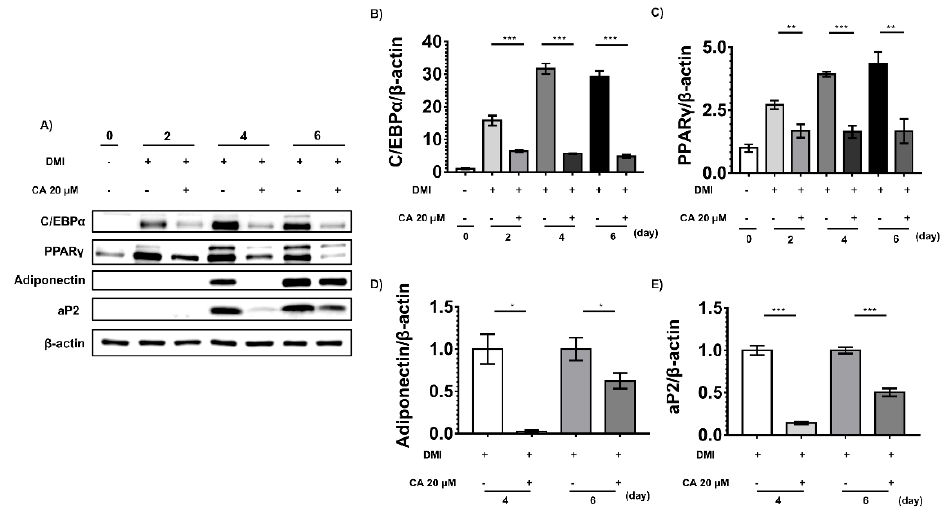
Figure 6. Effects of chebulinic acid (CA) on adipogenic factors and adipocyte markers. ( A ) Protein expression levels of adipogenic factors and adipocyte markers were detected three times independently using Western blotting. At the indicated time, 3T3-L1 cells were differentiated with dexamethasone, methylisobutylxanthine, and insulin (DMI) in the presence of 20 µ M chebulinic acid or 0.1% dimethyl sulfoxide (DMSO) as a negative control; ( B , C ) the quantified graphs of C/EBP α ( B ) and PPAR γ ( C ) normalized to non-differentiated group were shown; ( D , E ) since aP2 and adiponectin were not detected until day 2, these were normalized to control group in each treated day. Results are presented as the mean ± standard deviation (SD, n = 3) of three independent experiments; * p < 0.05, ** p < 0.01, and *** p < 0.001 compared with the control group.